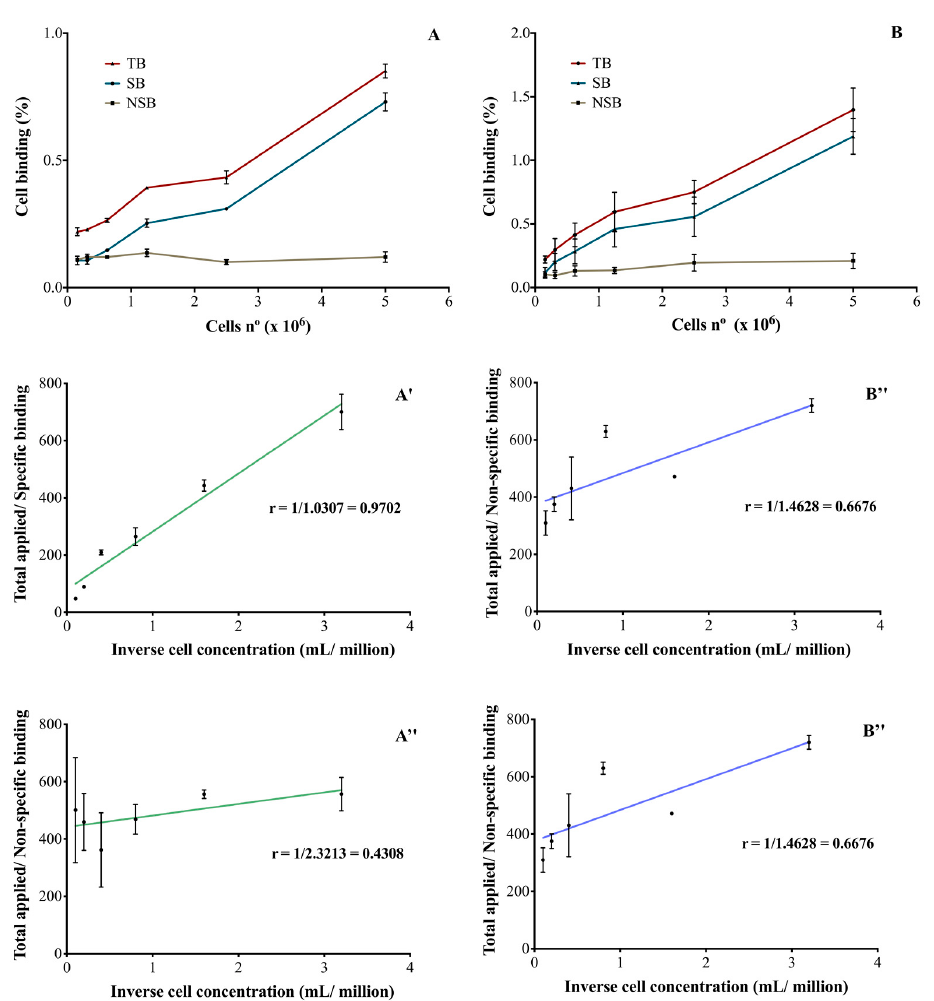
Figure 3. Percentage of RICs binding to SK-BR-3 cells (HER2-positive) of ( A ) [ 111 In]In-DTPA-trastuzumab and ( B ) [ 177 Lu]Lu-DOTA-trastuzumab and the evaluation of the immunoreactive fraction of the RICs: ( A ′ ) and ( B ′ ) specific binding to SK-BR-3 cells and ( A ″ ) and ( B ″ ) non-specific binding. TB—total binding; SB—specific binding; NSB—non-specific binding. The values are expressed as mean ± SEM ( n = 3).